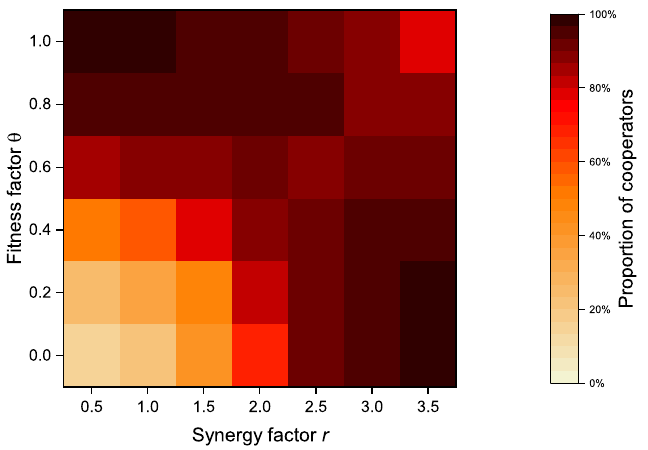
Figure 14. Cooperator proportion of the model for different synergy factors and different fitness factors when the zealots number is 10 and the proportion of altruistic nodes is set to